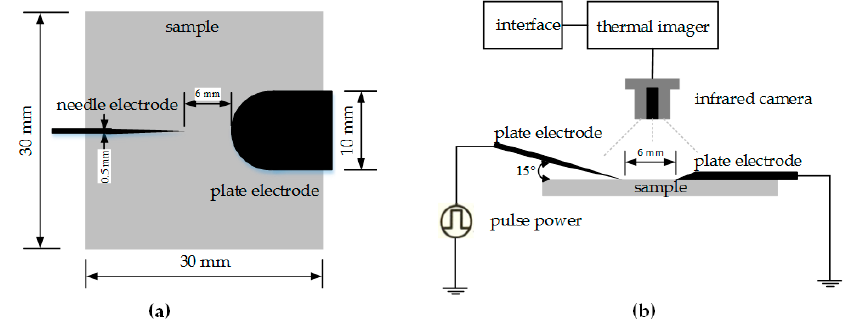
Figure 2. Schematic diagram of the platform for the surface breakdown tests. ( a ) Top view of sample; and ( b ) infrared thermograph platform for the surface breakdown tests under pulse power.